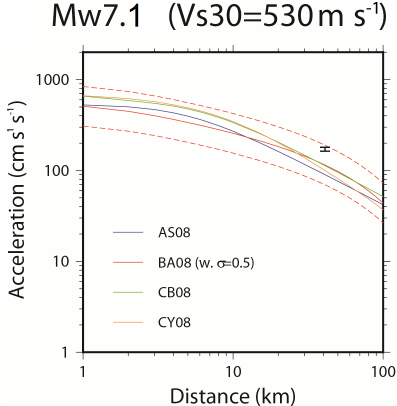
Figure 11. Estimated horizontal peak ground accelerations due to an earthquake of M w 7.1 from four ground motion prediction equa- tions: Abrahamson and Silva (2008; blue line), Boore and Atkin- son (2008; solid red line with ± 1 standard deviation in dashed lines), Campbell and Bozorgnia (2008; yellow line), and Chiou and Youngs (2008; green line). The error bar symbol shows more ac- curate estimates derived from hybrid broadband ground accelera- tion calculation at the site of interest, as proposed in Douilly et al. (2017). This combines the deterministic low-frequency part from the dynamic rupture simulation of Douilly et al. (2015) with the stochastic high-frequency one calculated through the specific bar- rier model (Papageorgiou and Aki, 1983) for a crossover frequency of